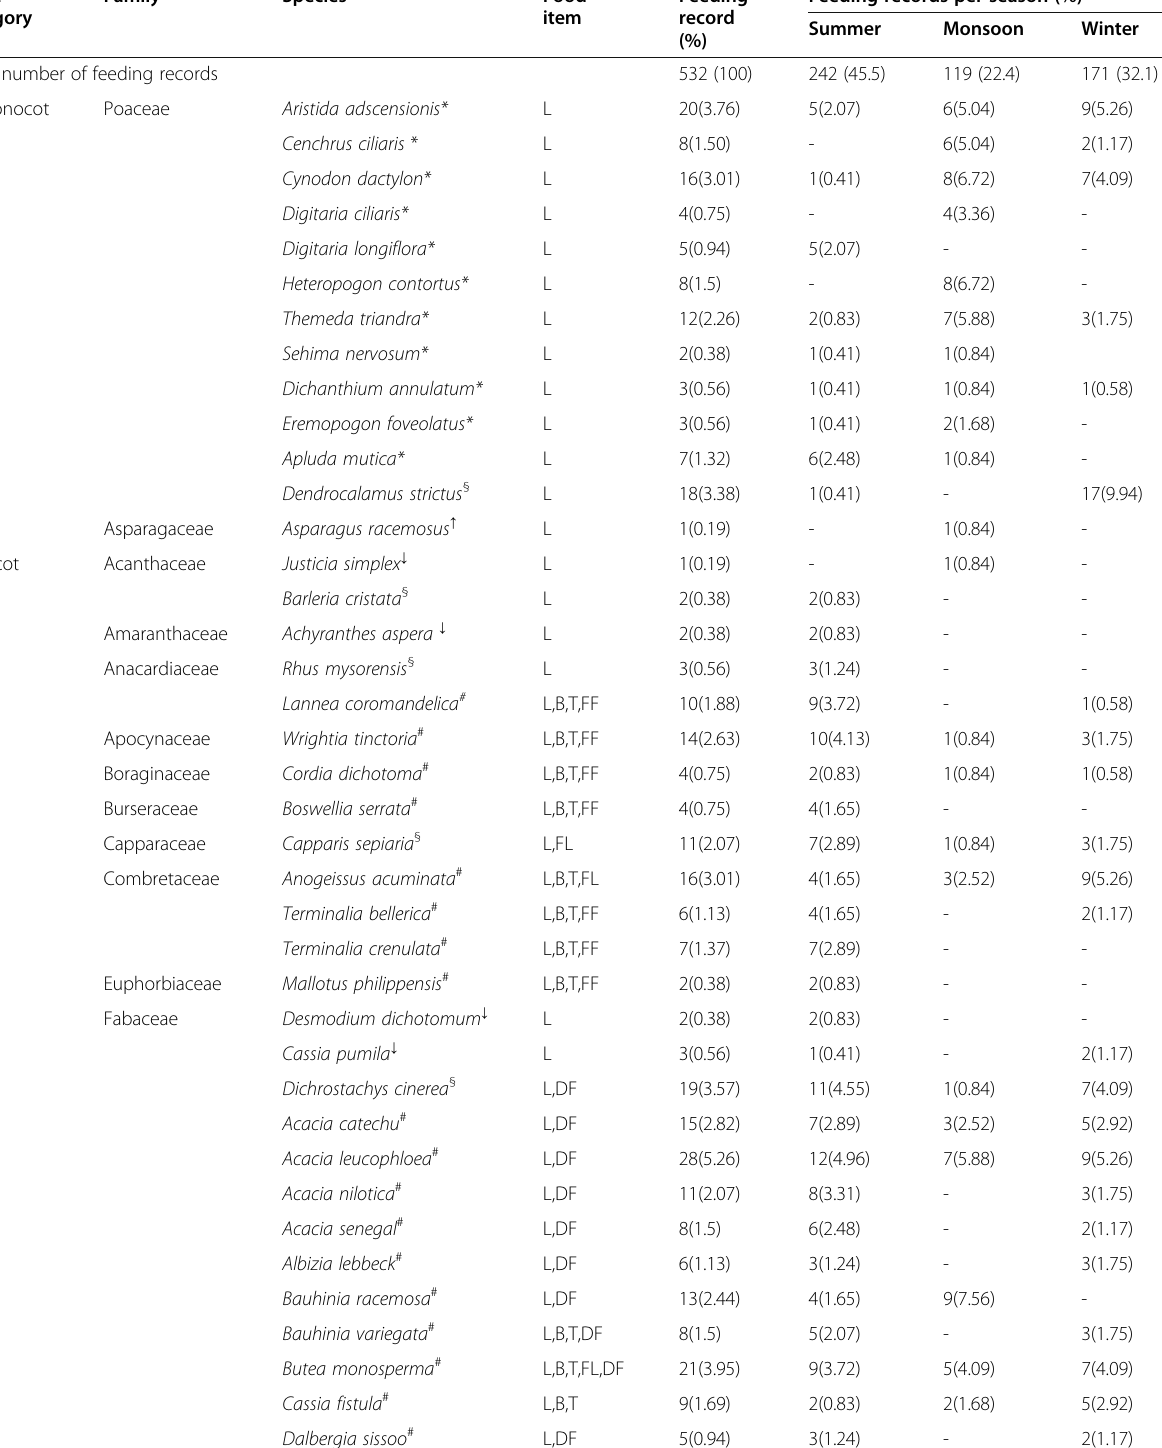
Table 5 Seasonal composition of Four-horned Antelope ( T. quadricornis ) diet in the tropical deciduous forest of southern Rajasthan, India (L= leaves, B=buds, T=twigs, FL=flower, FF=fleshy fruit, DF=Dry fruit/pod). Data is presented in number of feeding